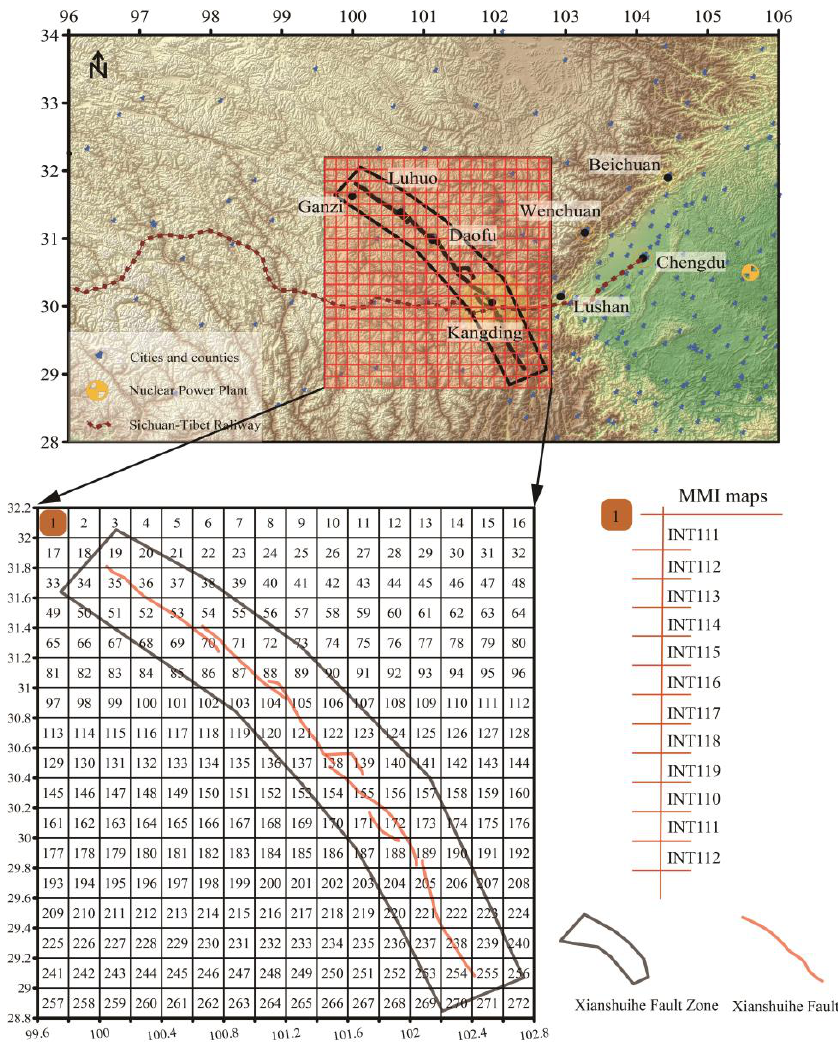
Figure 7. Study area with “protected” and “seismogenic” zone (28.8 ° ~32.2 ° N, 99.6 ° ~102.8 ° E) meshed by 0.2° × 0.2° grid. For each cell of the protected area, 12 MMI maps are computed. To optimize the size of the MMI database, we apply the same rules adopted to deter- mine the focal depth ( ℎ 𝑑 ) of earthquakes with different magnitudes in standard regional computations (e.g., [45]), i.e., ℎ 𝑑 = 10 for 𝑀 < 7 ; ℎ 𝑑 = 15 for 7 ≤ 𝑀 < 8 ; ℎ 𝑑 = 25 for 𝑀 ≥ 8 . In general, an 𝑀 = 5.0 earthquake is considered a damaging earthquake (Table 3). The maximum magnitude can be effectively defined by earthquake forecast/prediction algorithms (e.g., [71,72]) and morpho-structural analysis [35]. From the result of the ongo- ing M8 Time of Increased Probability (TIP) experiment, the maximum magnitude in XSH could exceed 8.0 [71]. As shown by [44], a M design = 8.7 was used in each seismogenic node prone to great earthquakes and only one node is included (Figure 7). Following the source gridding rule, in the source area there are 16 × 17 = 272 0.2° × 0.2° cells (Figure 7). For example, the cells numbered 1st~16th occupy the first row, 17th~32nd occupy the second row, and the last cell is the 272nd. In order to take all possible earthquake scenarios into consideration, 12 simplified regional computations are performed in 272 cells, with the following procedures: